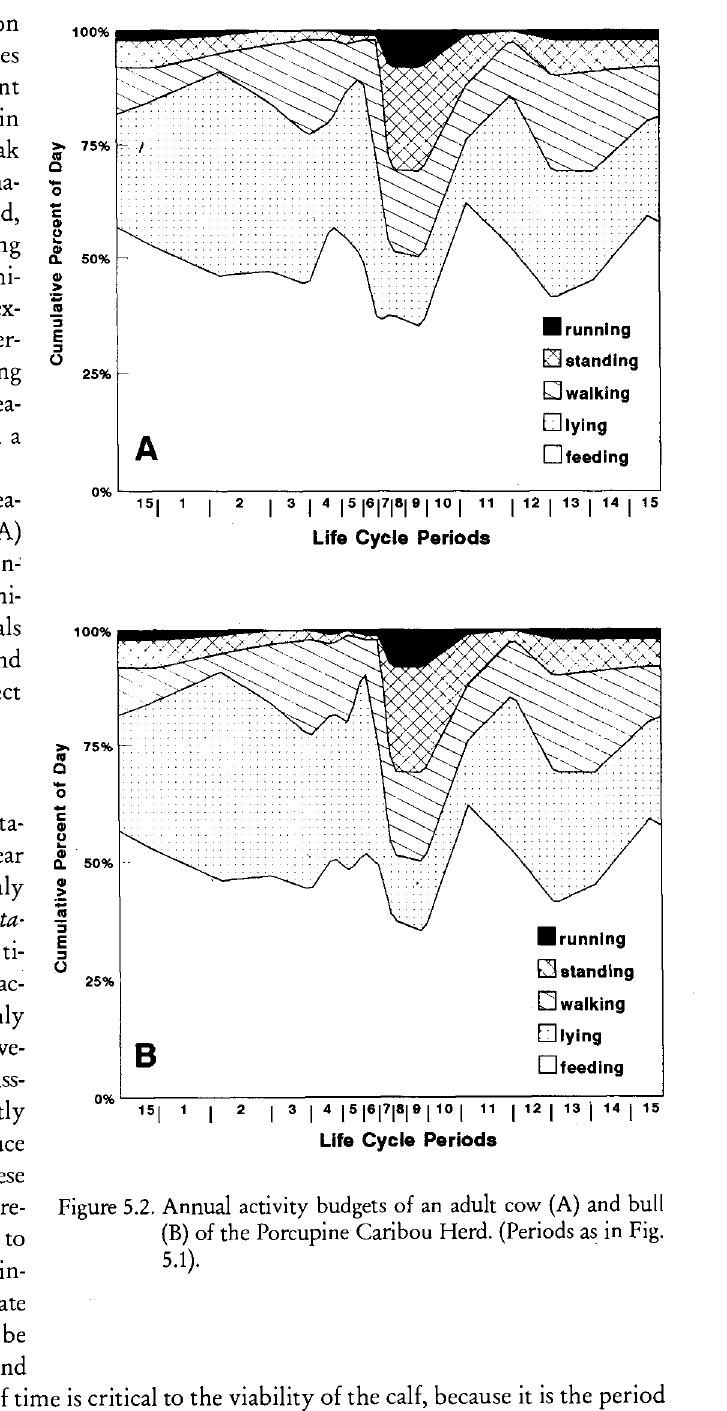
Figure 5.2. Annual activity budgets of an adult cow (A) and bull (B) of the Porcupine Caribou Herd. (Periods as in Fig.